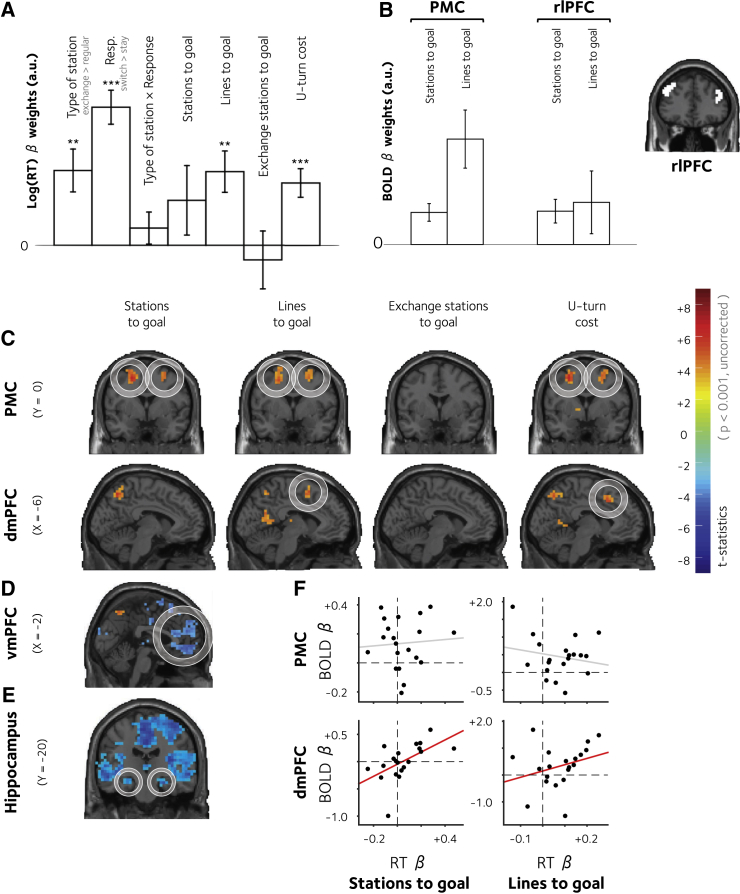
Behavioral and Neural Costs of Flat and Hierarchical Planning(A) Regression coefficients (mean ± SEM across participants) showing the slope of the predictive relationship between experimental variables (including distance estimates) and log RTs.(B) Parametric responses (mean ± SEM) to DS and DL in the PMC and rlPFC. There is a significant condition × region interaction. The rlPFC ROI is shown on the right.(C) Encoding of the four plan complexity measures (GLM1) in the lateral (coronal view; upper) and medial (sagittal view; lower) frontal cortices, rendered onto a template brain, thresholded at p < 0.001 uncorrected.(D) Correlation with proximity to goal (GLM1) in the vmPFC.(E) Correlation with proximity to goal (GLM2) in the hippocampus. The activations are shown that exceed p < 0.001, uncorrected.(F) Correlation between parameter estimates linking log(RT) to plan complexity in units of station (left) and lines (right), with beta values encoding the corresponding distance measure in the PMC (upper) and dmPFC (lower). The dots correspond to individual subjects. The lines are to best linear fits for significant (red) and non-significant (gray) correlations, respectively.The significant regions within a circle survived multiple comparisons correction.